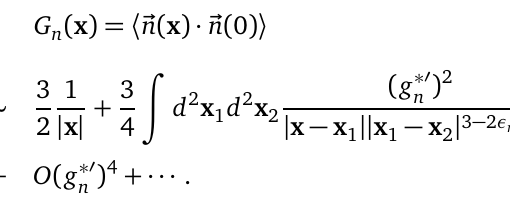
Figure 3: The RG flow of ( λ , g parameters will flow to positive infinity, which implies that the boundary will likely develop the Ising-VBS order before the